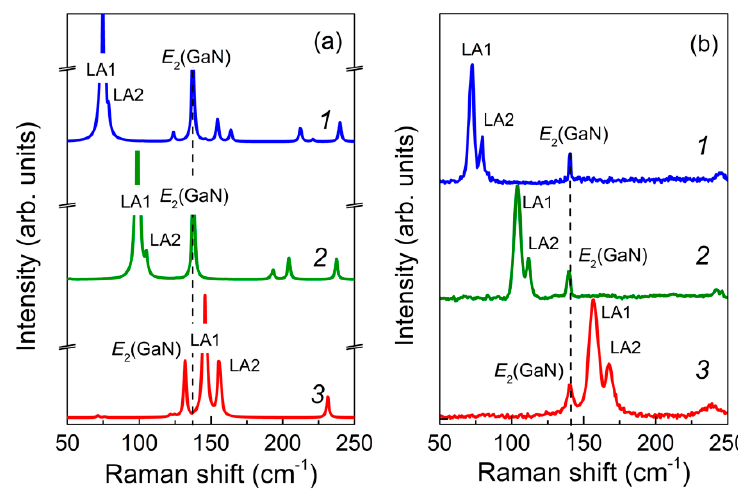
Figure 2. The low-frequency parts of the calculated ( a ) and experimental ( b ) Raman spectra in the z(xx)z scattering geometry for the (GaN) m /(AlN) n SLs with m / n = 8/8 ( 1 ), 6/6 ( 2 ), and 4/4 ( 3 ). One can see that the experimental and calculated z(xx)z Raman spectra agree well.